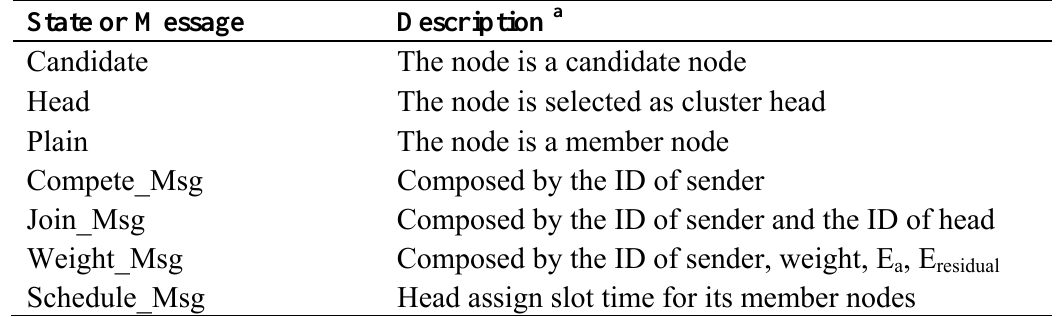
Table 1. Descriptions of States and Messages.